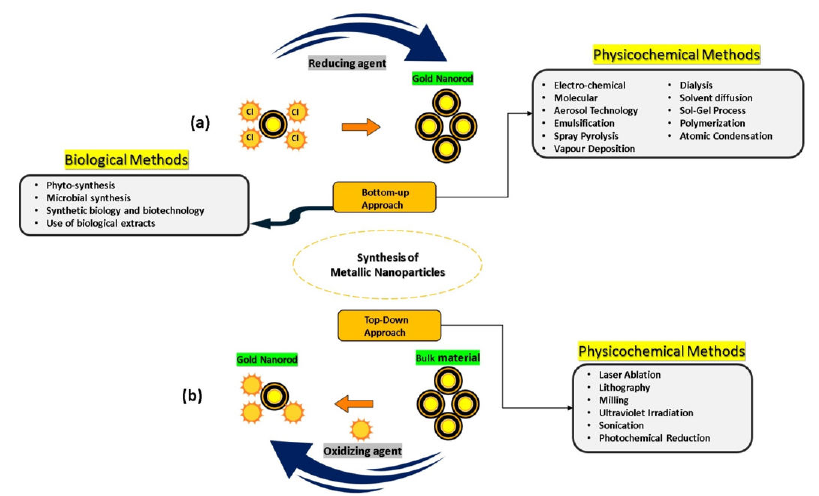
Figure 5. Strategies the synthesis of GNR using traditional physiochemical and relatively novel eco-friendly biological methods ( a ) from the bottom-up and ( b ) top-down